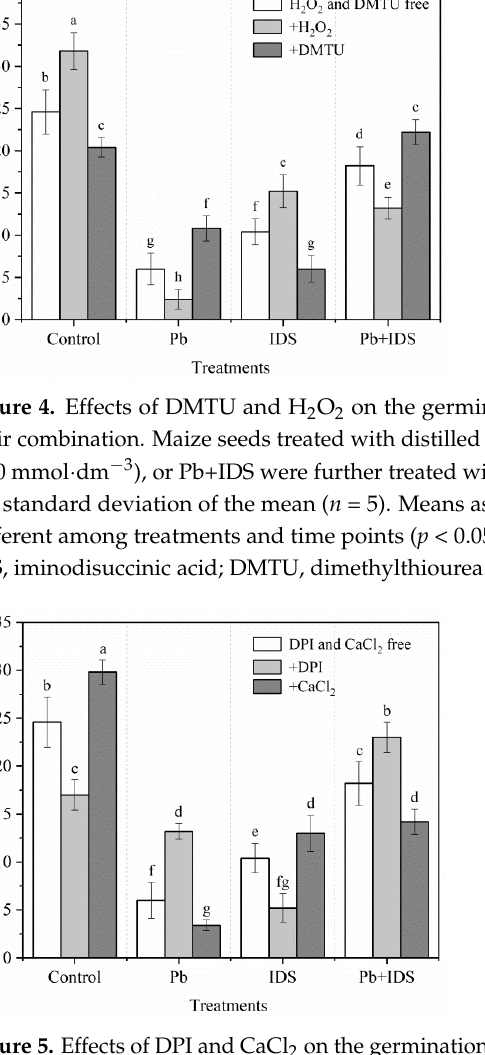
Figure 4. Effects of DMTU and H 2 O 2 on the germination of maize seeds treated with IDS, Pb, or their combination. Maize seeds treated with distilled water (control), Pb (20 mmol·dm −3 PbCl 2 ), IDS (100 mmol·dm −3 ), or Pb+IDS were further treated with DMTU or H 2 O 2 for 1 d. Error bars represent the standard deviation of the mean ( n = 5). Means associated with different letters are significantly dif- ferent among treatments and time points ( p < 0.05; Duncan’s new multiple range test). Pb, lead; IDS, iminodisuccinic acid; DMTU, dimethylthiourea.